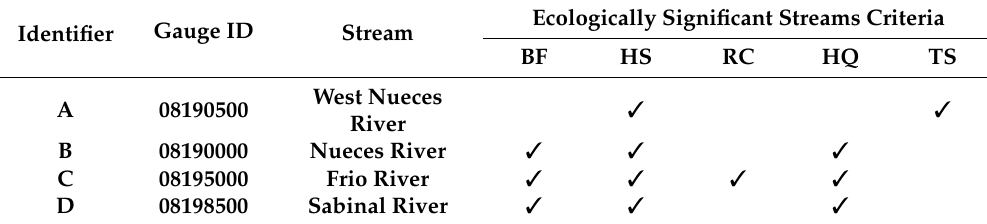
Figure 3. Hydroclimatic Data Network gauge locations (see Table 1 for gauge information). Table 1. Functions of the significant streams in the study